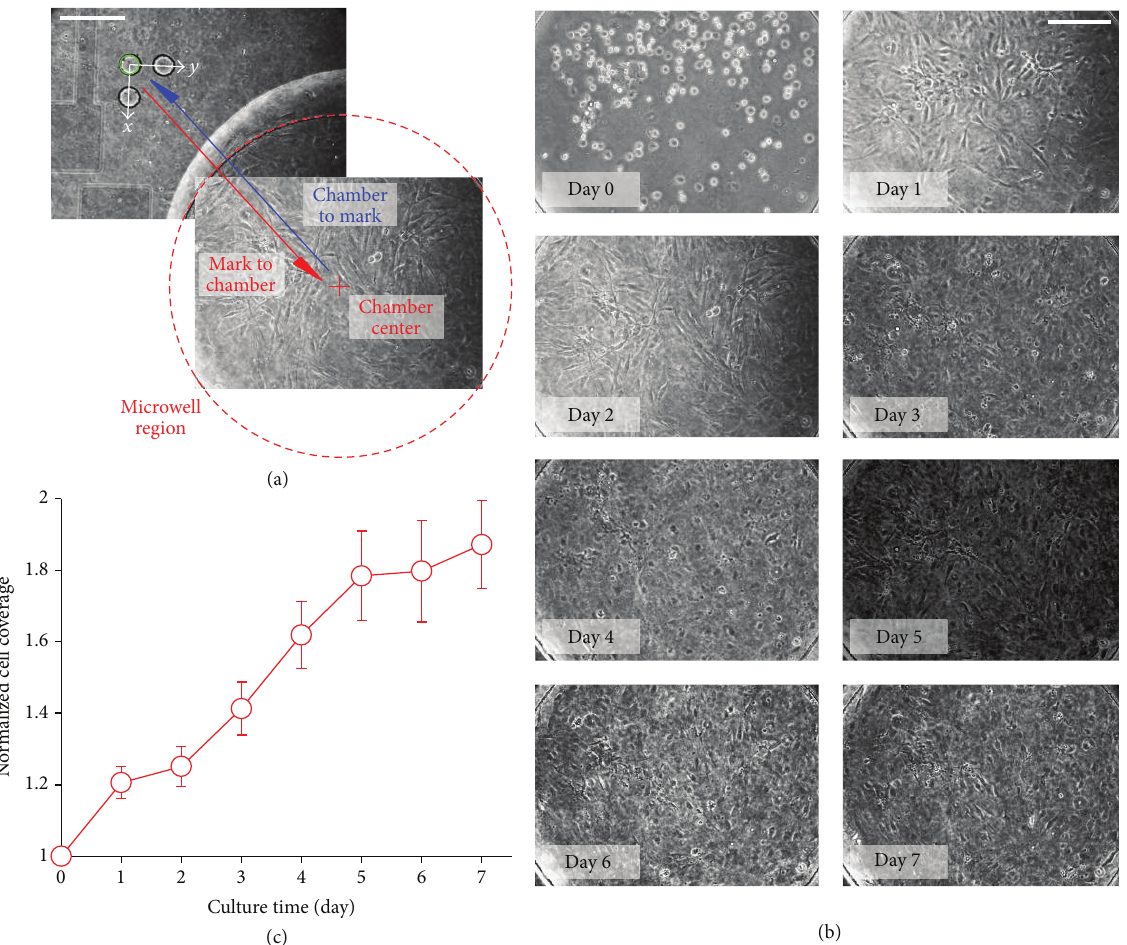
Figure 8: Implementation of automated monitoring of parallel cell culture. (a) Switch between cell alignment mark and chamber center for imaging. Scale bar: 250 𝜇 m. (b) Example of cell seeding (day 0) and cell growth (day 1–7) in a representative chamber. Scale bar: 250 𝜇 m. (c) Normalized cell coverage in microchambers of the microfluidic device. Error bars represent the standard errors with each calculated from 5–20 data